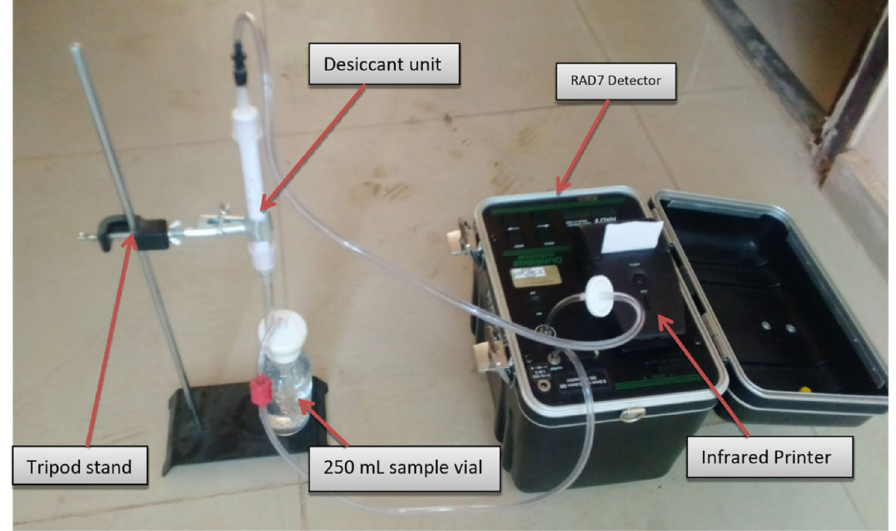
Figure 2. The setup of the RAD7 detector used to measure Rn ‐ 222 activity in water